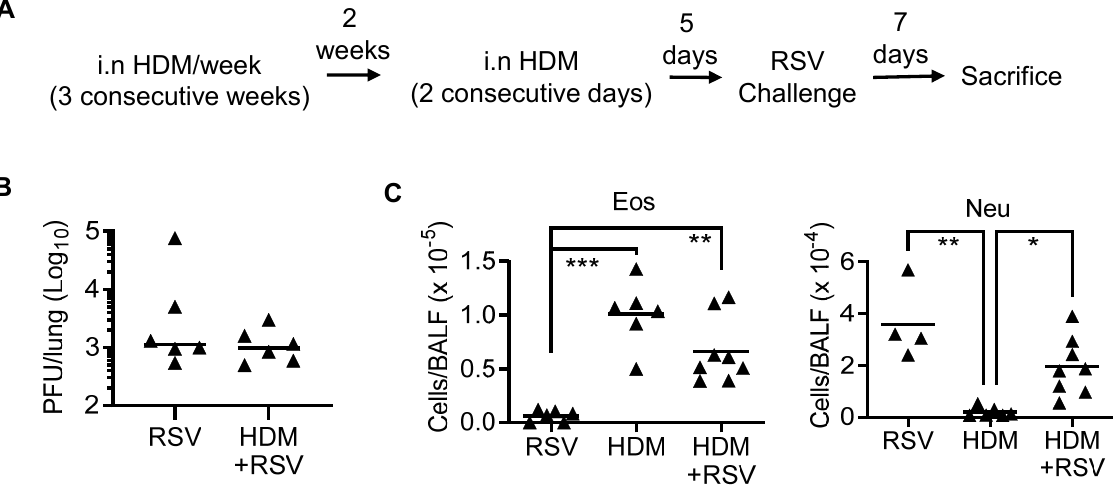
Figure 4. RSV infection of WT mice with HDM ‐ induced asthma induces moderate levels of eosinophilic and neutrophilic inflammation . ( A ) Scheme of the experimental design. ( B ) Lung RSV titers and ( C ) numbers of airway eosinophils and neutrophils at day 7 after 10 5 PFU RSV infection of HDM ‐ induced asthmatic C57BL/6 WT mice. * p < 0.05, ** p < 0.01, *** p < 0.001, one ‐ way ANOVA with Tukey’s multiple comparisons’ test. Data shown are representative of at least two independent experiments.